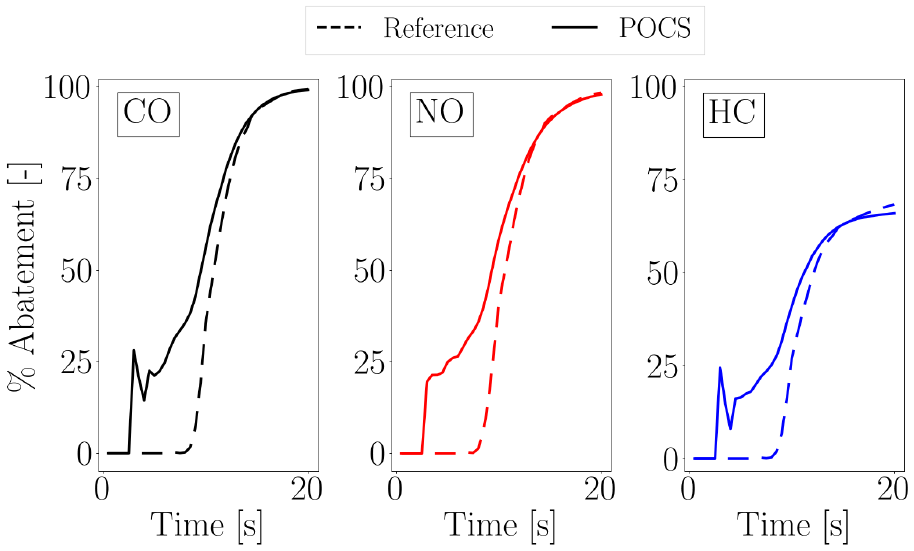
Figure 20. Cold start assessment: pollutants’ percentage abatement